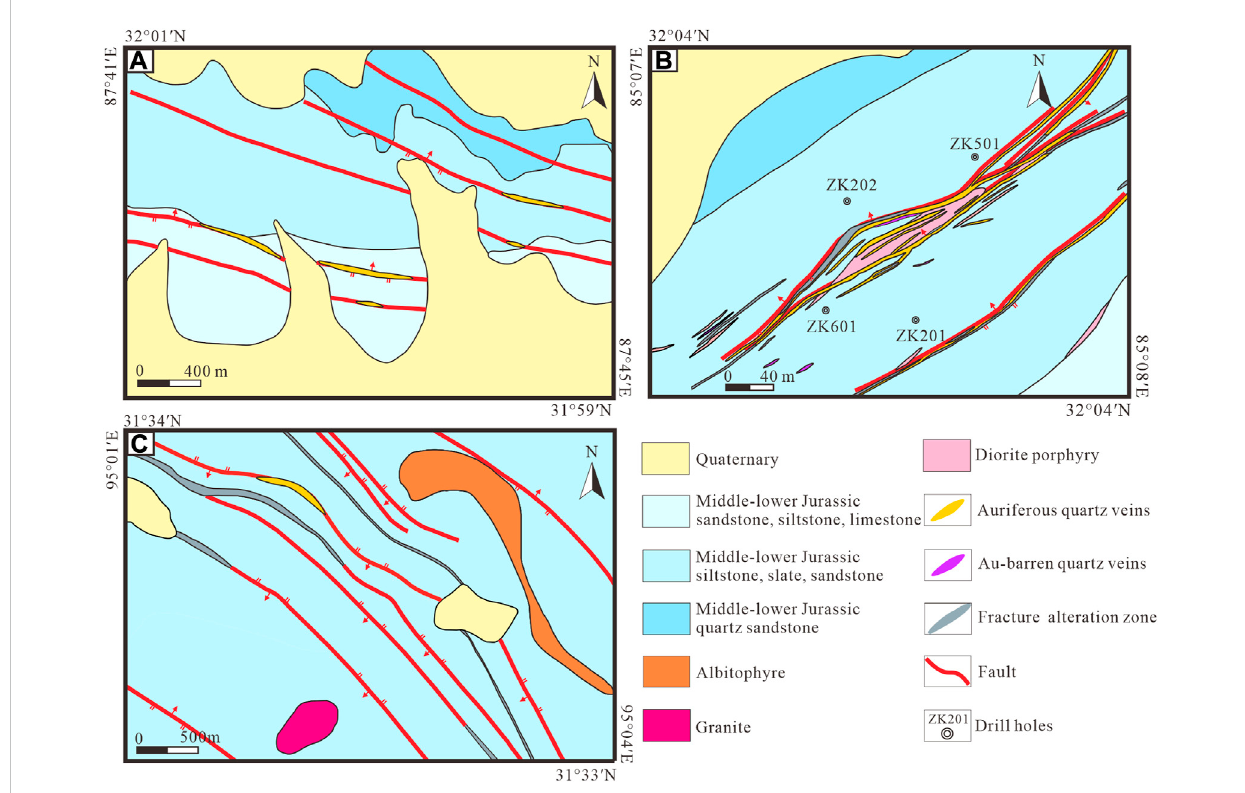
FIGURE 7 Geology of orogenic gold deposits. (A) Shangxu deposit (modi fi ed from Huang et al., 2014), (B) Dacha (Wusuola) deposit (modi fi ed from Tibet Institute of Geological Survey, 2010), and (C) Zhagela deposit (modi fi ed from Zhang et al.,